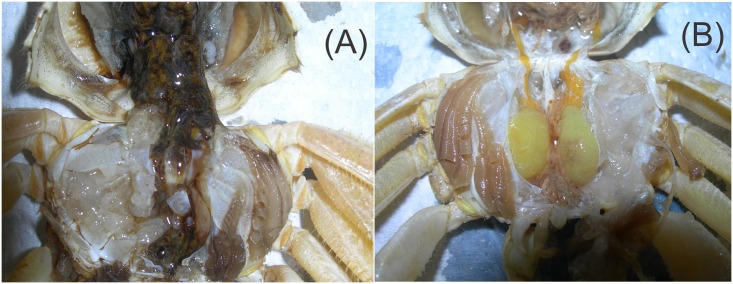
Effects of Octopus maya saliva on ghost crab.Ocypode quadrata: (A) tissue hydrolysis and death caused by the metabolic fraction (> 3 kDa); (B) organs still intact after the crab had recovered from paralysis and relaxation induced by the neurotoxic fraction (< 3 kDa).